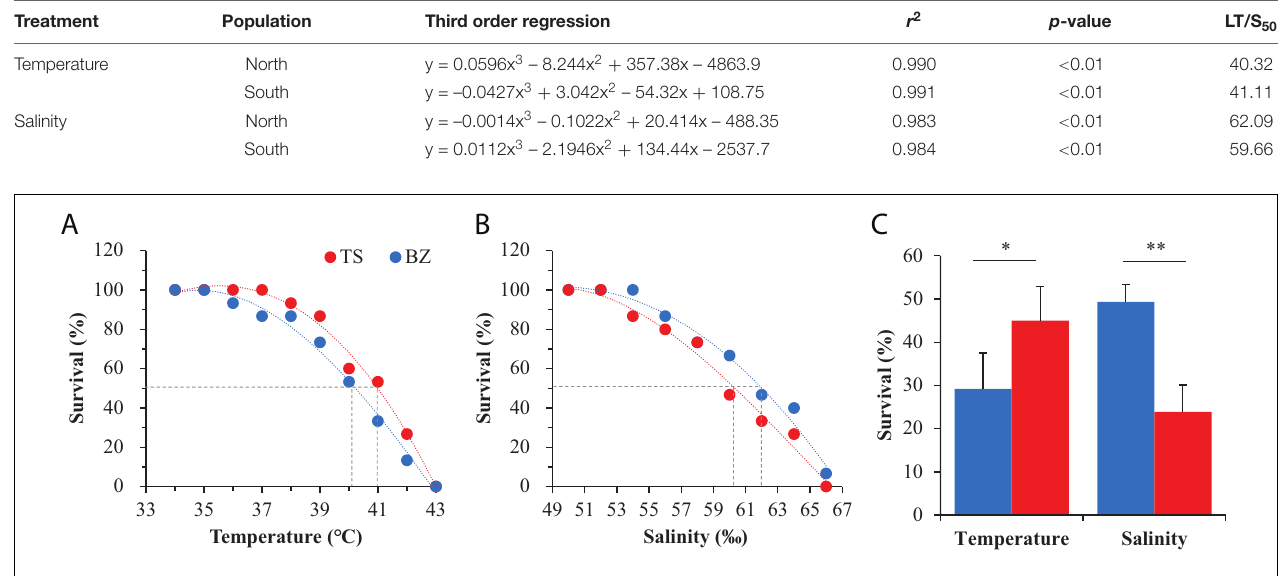
FIGURE 4 | Responses to heat shock and high salinity of the northern (BZ, blue) and southern (TS, red) oysters. (A) LT 50 and (B) LS 50 determinations for the northern and southern F 1 oysters in their native habitats when exposed to high temperature and salinity gradients, respectively. (C) Survival of the northern and southern F 1 progeny after exposure to the LT 50 of the southern population and the LS 50 of the northern population acclimated to the northern environment.